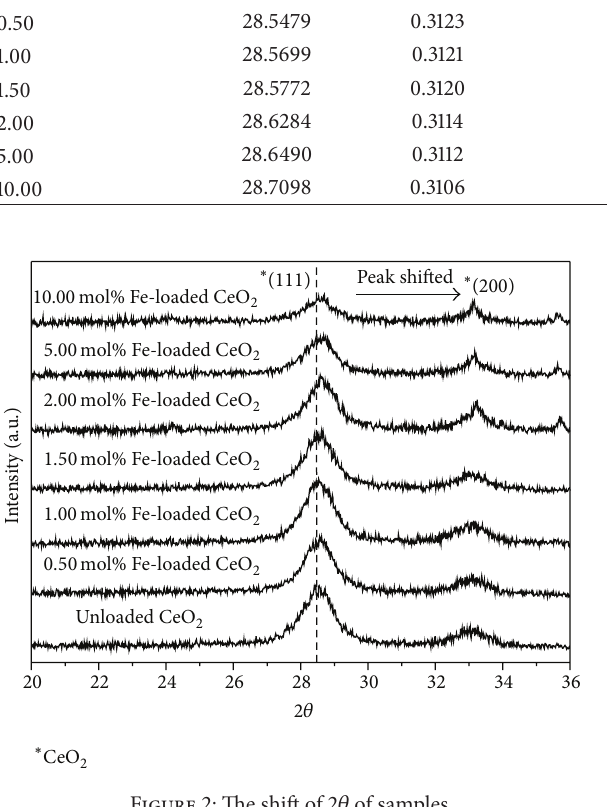
Figure 2: The shift of 2 𝜃 of samples.